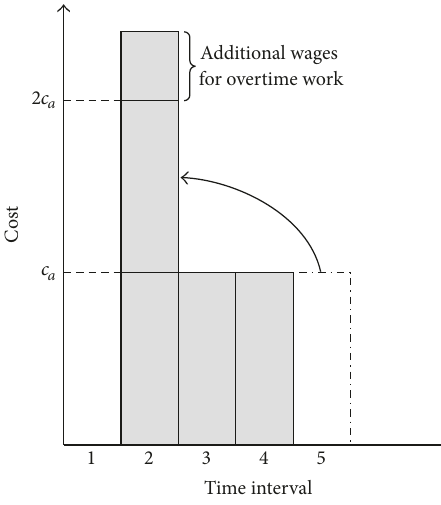
Figure 3: Illustration of construction costs for a